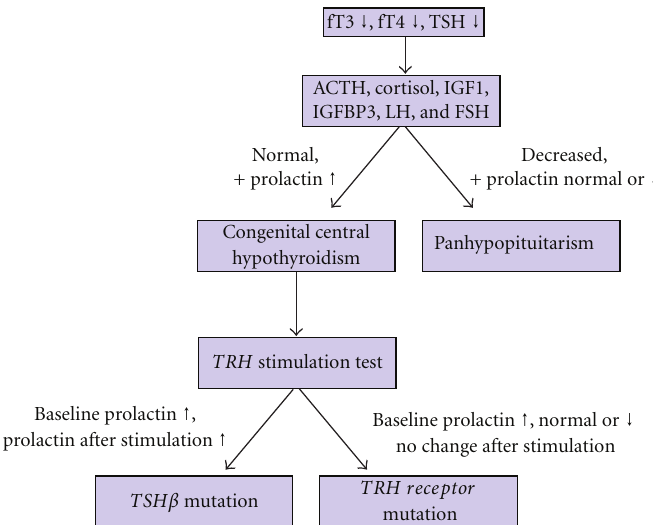
Figure 3: Proposed diagnostic workup in CCH for di ff erentiation between a panhypopituitarism, a TRH-receptor gene mutation and a TSH β -gene mutation. Rare other conditions mimicking CCH, such as hypothyroxinemia due to prematurity, primary hypothyroidism with delayed TSH elevation, and transient CCH must also be ruled